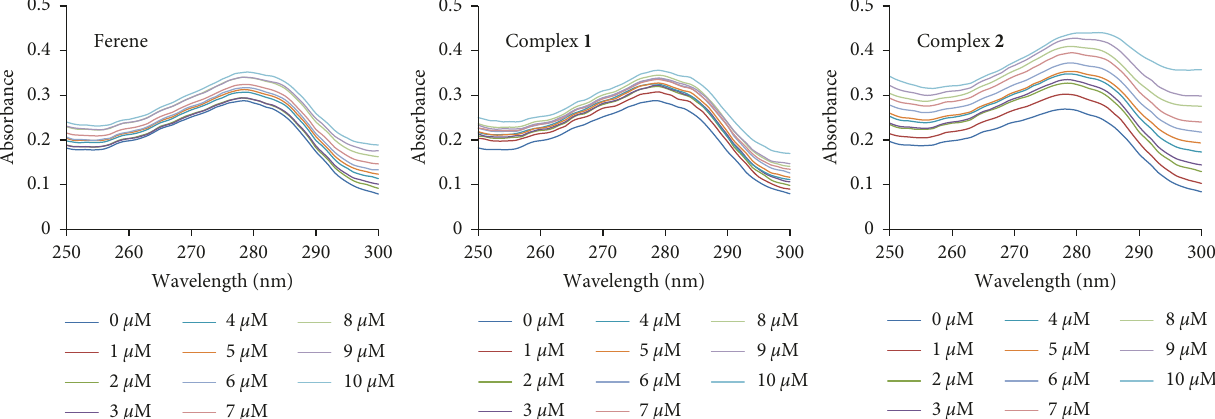
0.9955), complex 1 ( R 2 (cid:30)